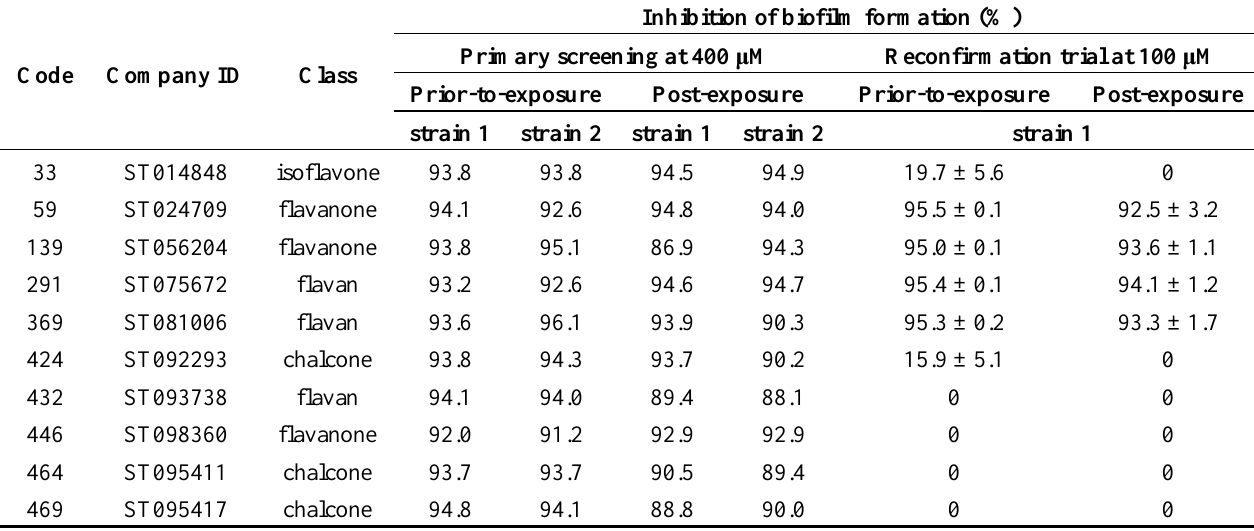
Table 1. Results from the first screening assay and reconfirmation trial for the ten flavonoids originally classified as highly active (summarized in Scheme